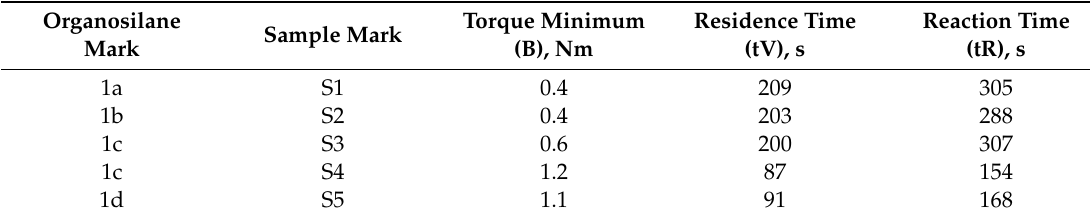
Figure 7. Flow-curing behavior of the EMCs. Table 4. Flow-curing behavior properties in regard to different organosilanes.